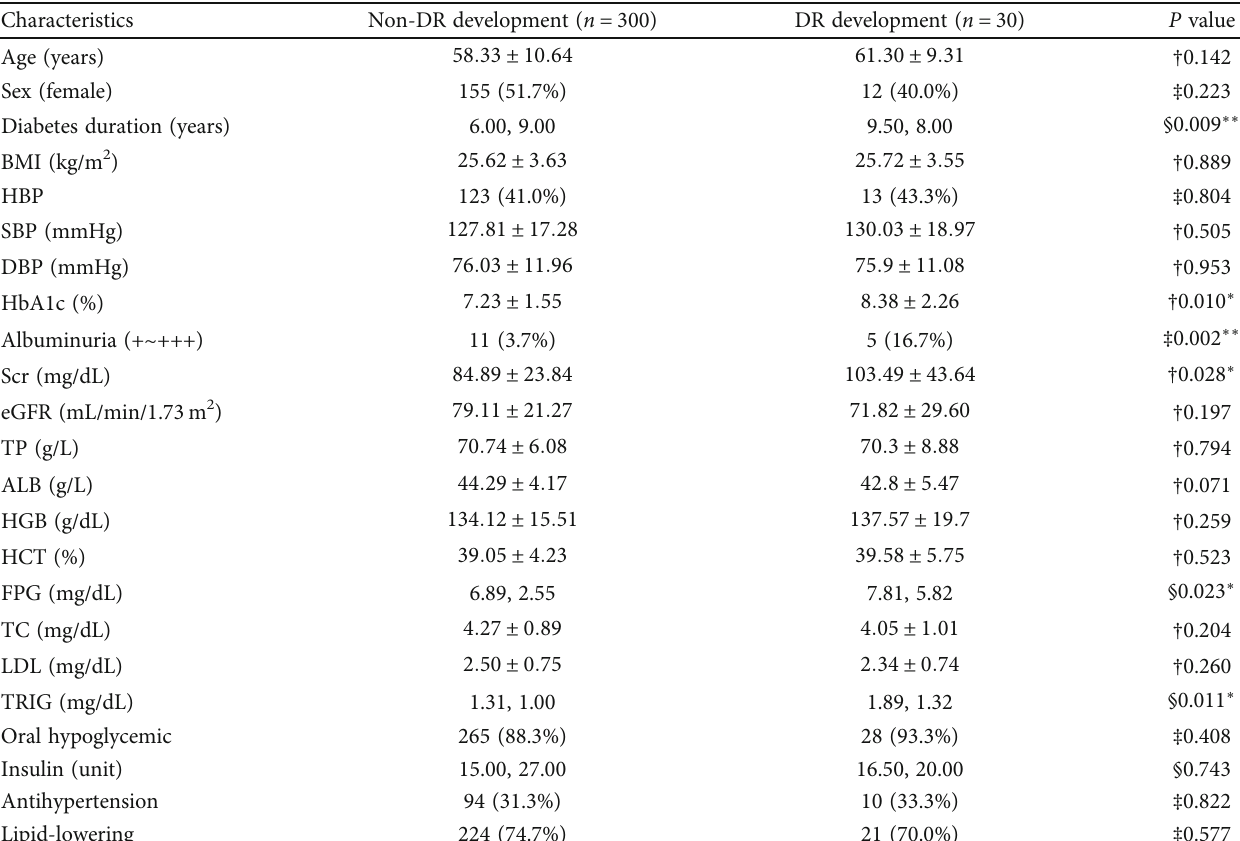
Table 1: Characteristics of DR nondevelopment group and DR development group.